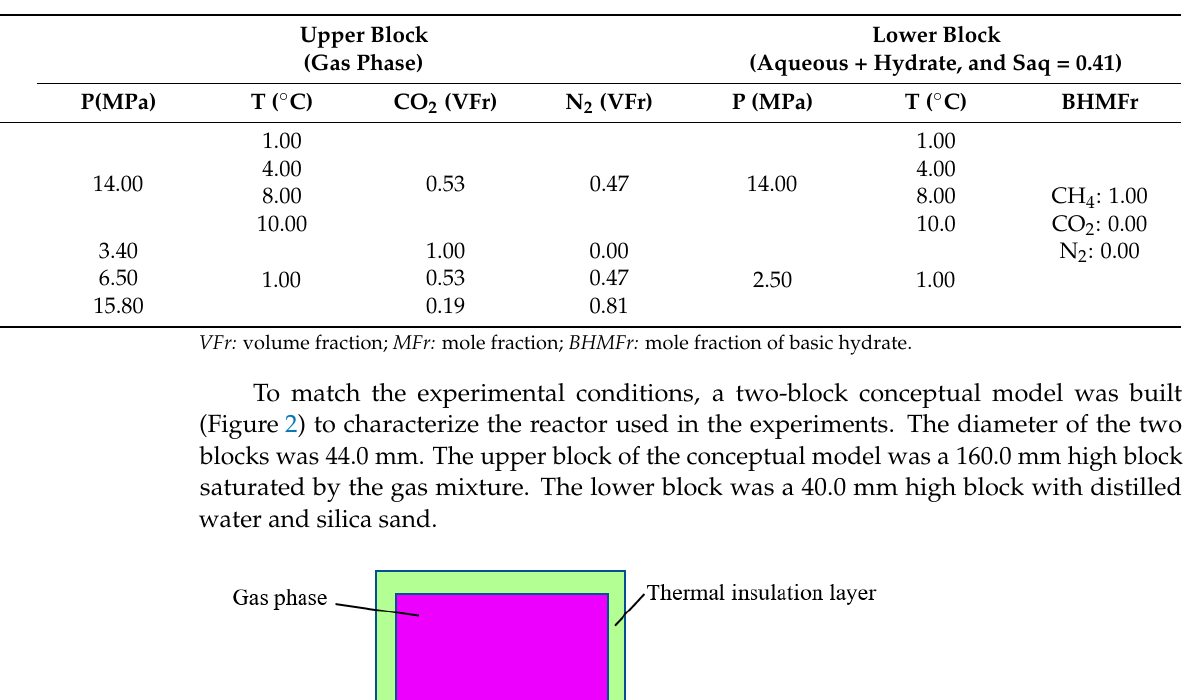
Table 6. Cases used in the veri fi cation. Case No.